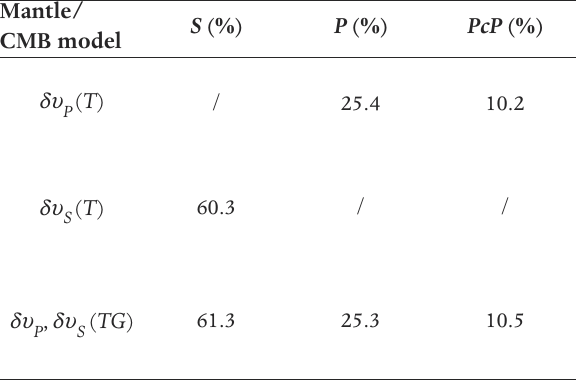
Table 1. Variance reductions of different databases (columns) achieved by models T and TG , as indicated. Note that model T consists of the results of two entirely decoupled inversions (first and second row), as in Della Mora et al. (2011), while model TG (third row) is an individual, joint model including both y anomalies.